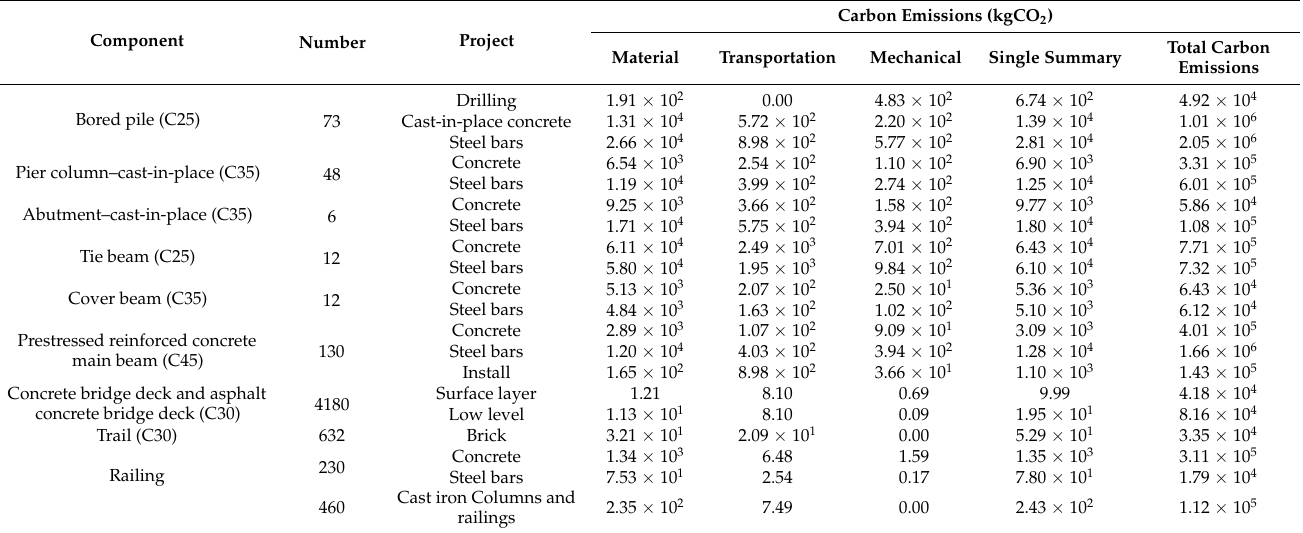
Table 2. Summary of component information and carbon